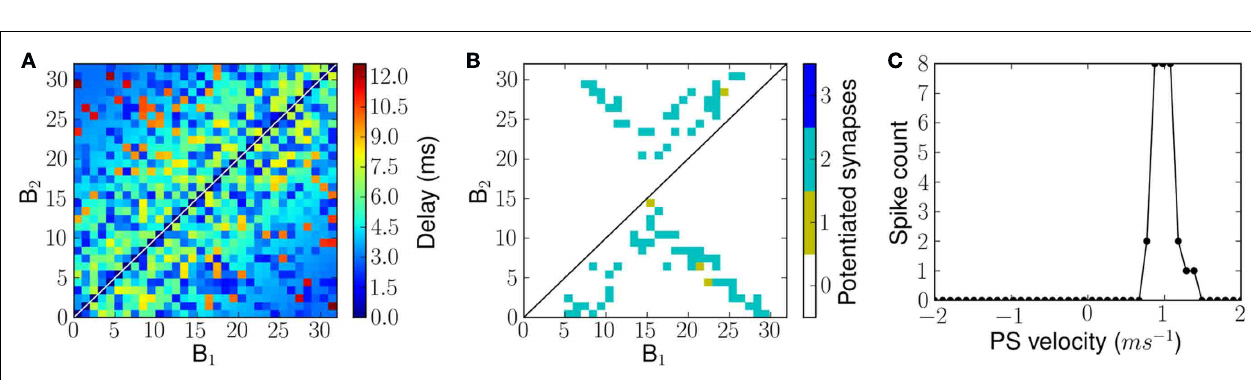
FIGURE 11 | Connectivity and FM sweep tuning curve of a network with random transmission delays from B 1 neurons to B 2 neurons. (A) Transmission delays from B 1 neurons to B 2 neurons. (B) The number of